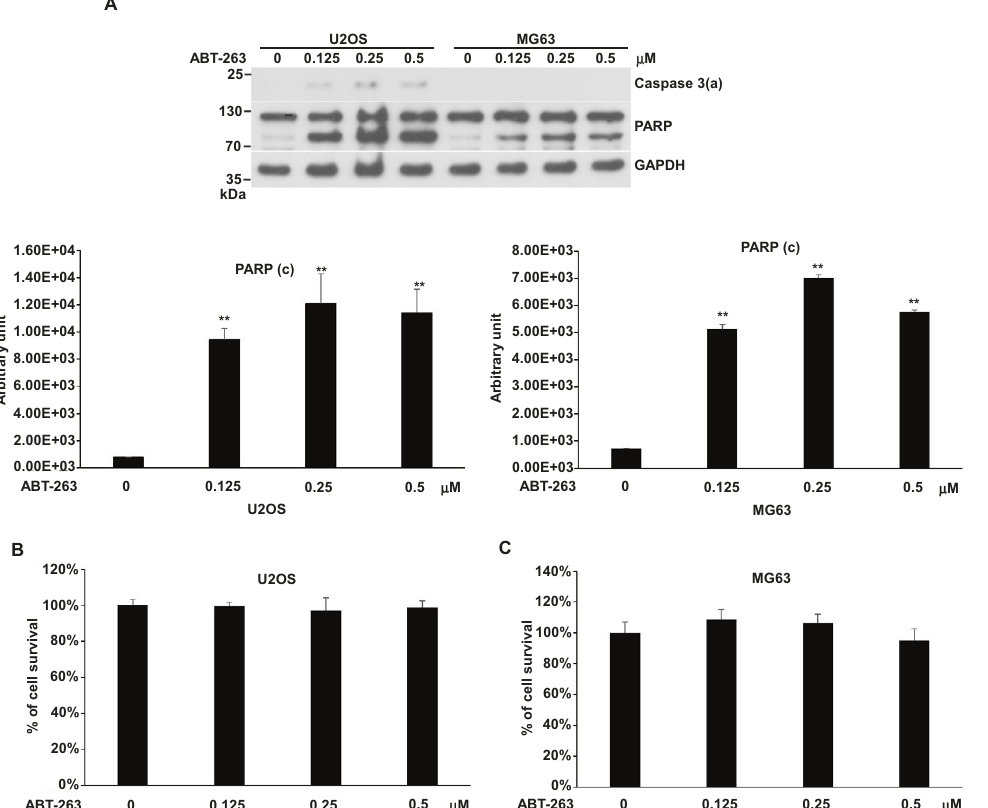
Fig. 3 Effects of ABT-263 on apoptosis in U2OS and MG63 cells. Cells were incubated with various concentrations of ABT-263 in 10-cm plates or 96-well plates for 24 h and harvested for western blotting or cell survival assay, respectively. The immunoblot images of caspase 3(a) and PARP were shown. GAPDH served as a loading control. Immunoblot images of PARP (c), the cleavage PARP, normalized to GAPDH were quantitated as shown below immunoblot image (** P < 0.01). The percentages of cell survival normalized to the cells without compound treatment were shown. The immune blots were cropped from different parts of the same gels and visualized by ECL with various exposure conditions dependent on the activity of antibodies. Representative blots from triplicate experiments were shown. A Immunoblot image of U2OS and MG63. B U2OS cell survival. C MG63 cell